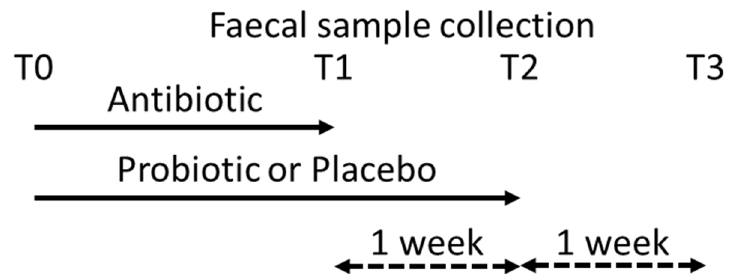
Figure 1. Schematic representation of fecal sample collection and study timeline. T0 is baseline, T1 is at the end of antibiotic treatment, T2 is one week after antibiotic treatment was stopped and the last day of probiotic supplementation, and T3 is two weeks after antibiotic treatment was stopped and one week after probiotic supplementation was stopped.